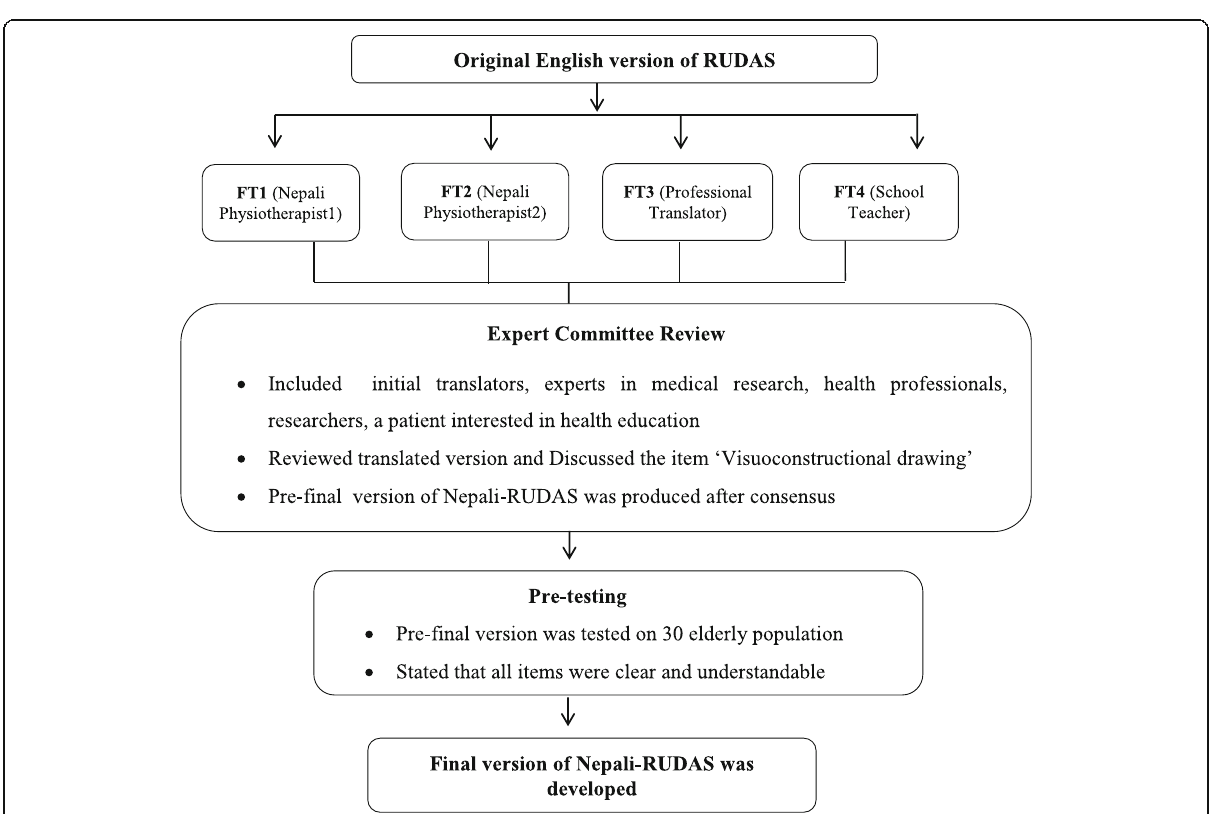
Fig. 1 Process of translation and cross-cultural adaptation of